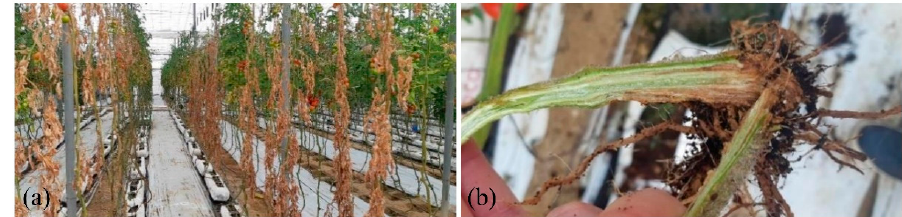
Figure 5. Fusarium oxysporum f. sp. radicis-lycopersici damage ( a ) and root detail ( b ).